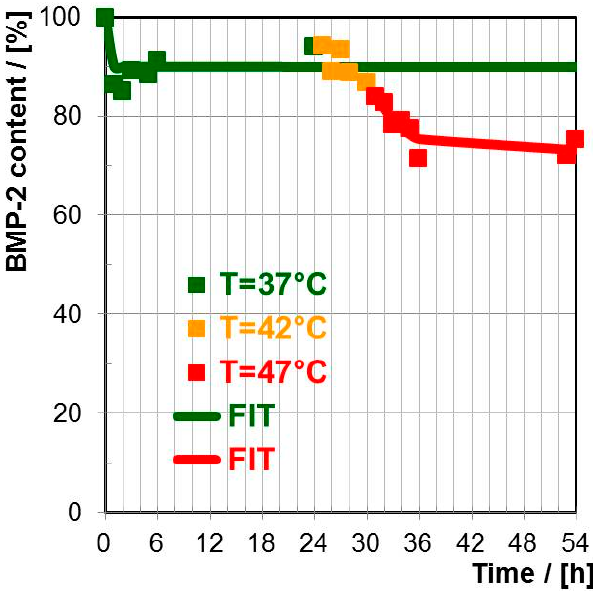
Figure 7. Release kinetics of BMP-2 out of BMP-2 loaded PNIPAM-DMAEMA/CS (PEC-1.2, 0.01